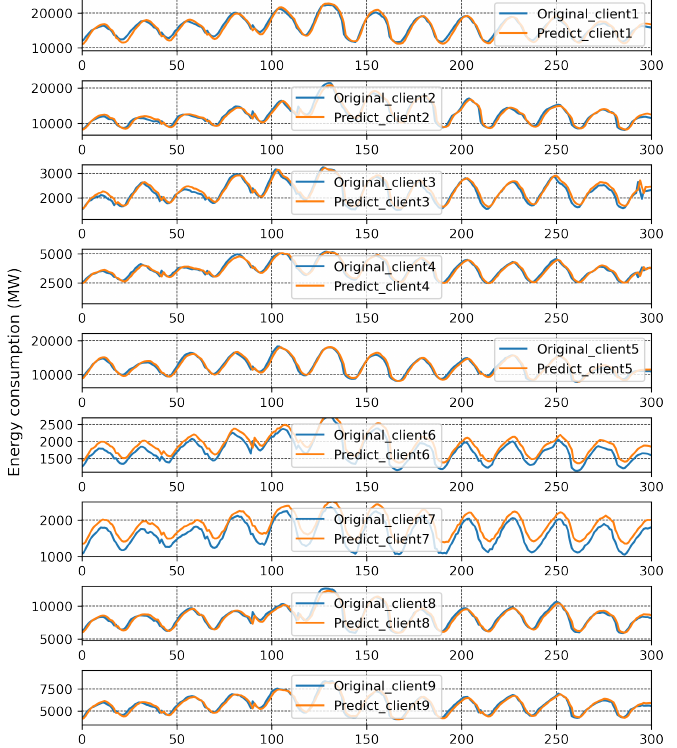
Figure 5. Prediction results with one global